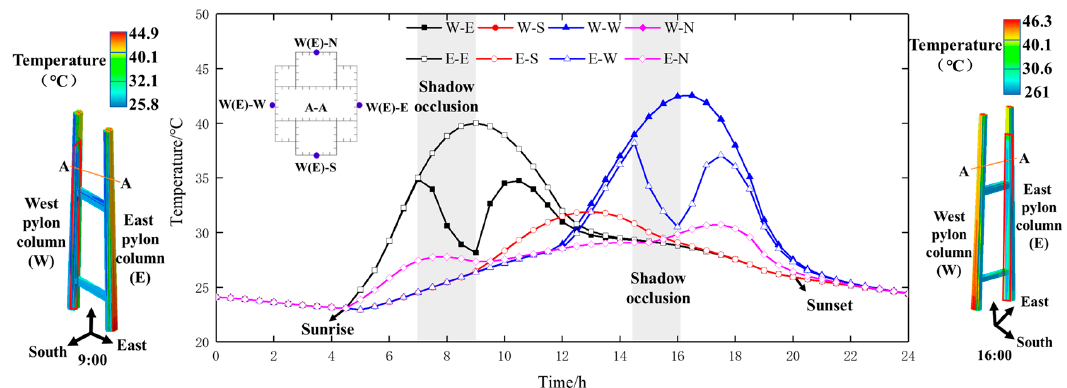
Figure 13. Temperature variation curve of cross-section A-A on bridge pylon in summer.